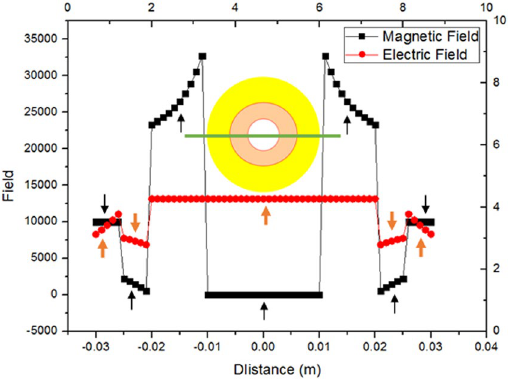
Figure 2. The relation between the permeability μ 2 and the radii ratios a / b . The different radii ratios and correspondingly permeability can obtain the same cloaked